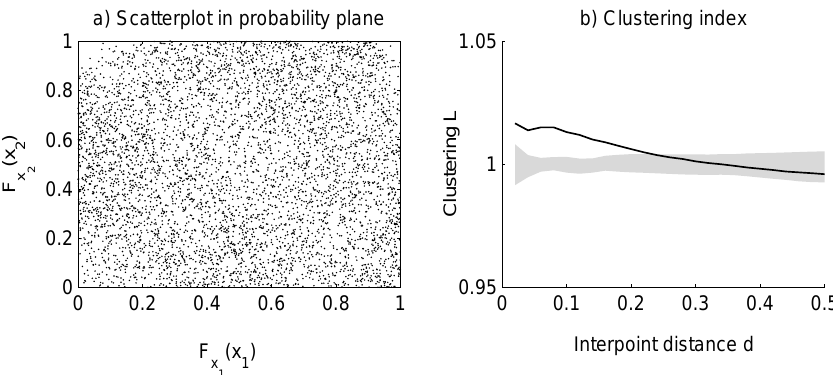
Fig. 8. Scatter plot of the leading two Isomap times series within the probability plane (a) and the associated clustering L-curve (b) . The shading in (b) represents the upper and lower envelopes of clustering indexes obtained from 100 simulated homogeneous Poisson point process.